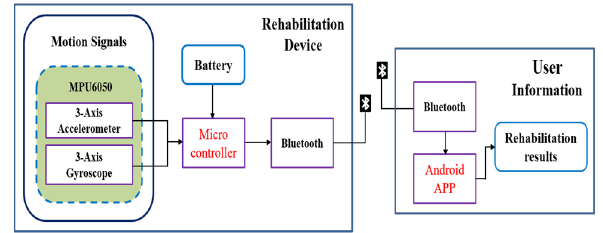
Figure 2. Structure of the proposed system.